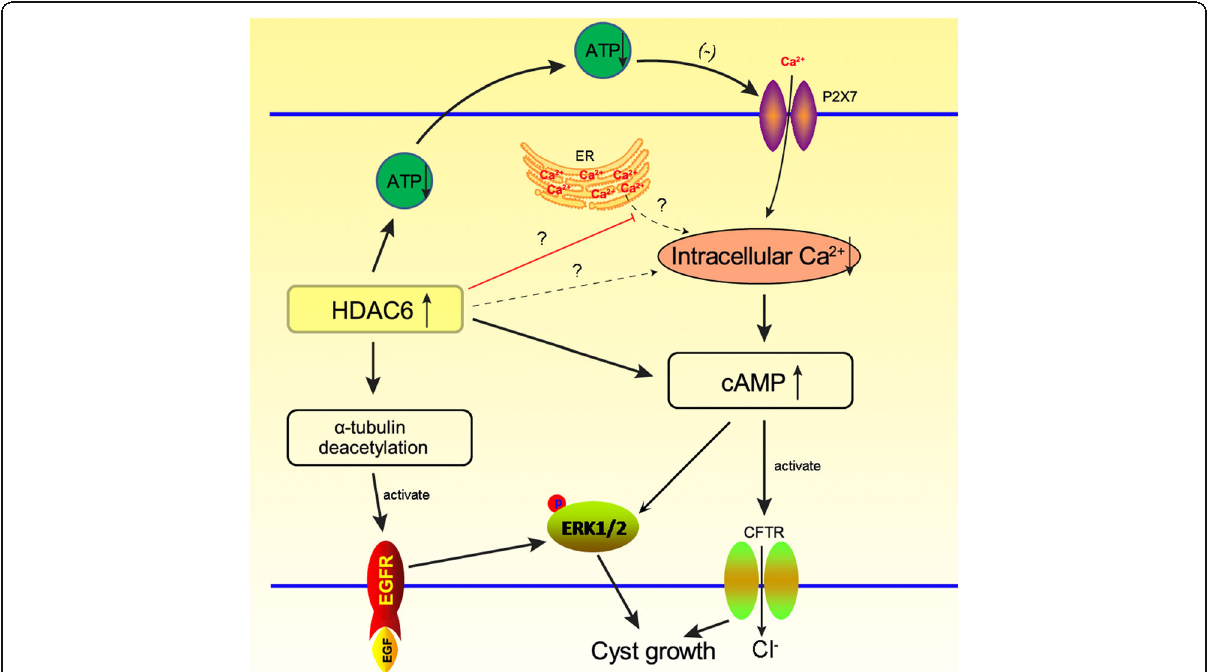
Fig. 2 Schematic presentation of the signalling pathways by which HDAC6 contributes to cyst growth by promoting cell proliferation and fluid secretion induced by aberrant Ca2+ signalling, abnormal cAMP signalling, and prolonged EGFR